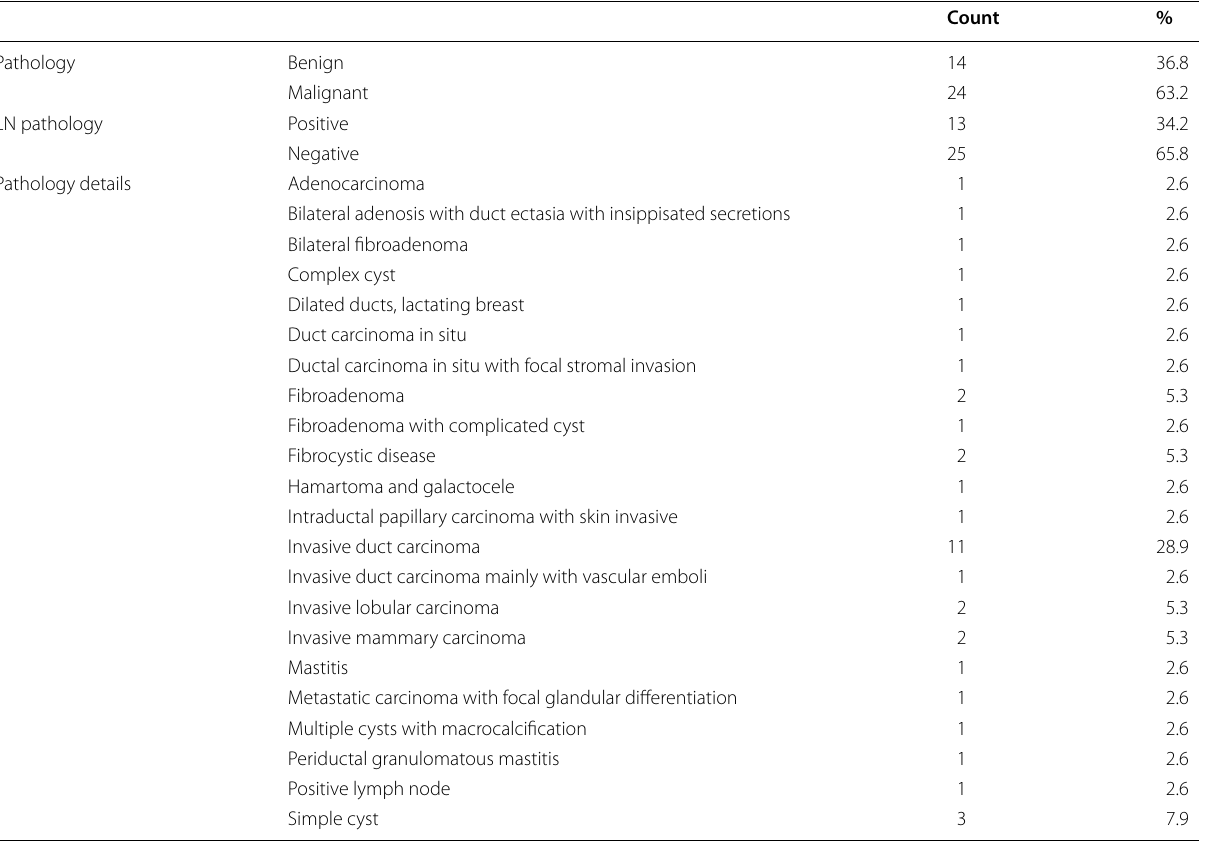
Table 2 The histological diagnosis in the patients included in our